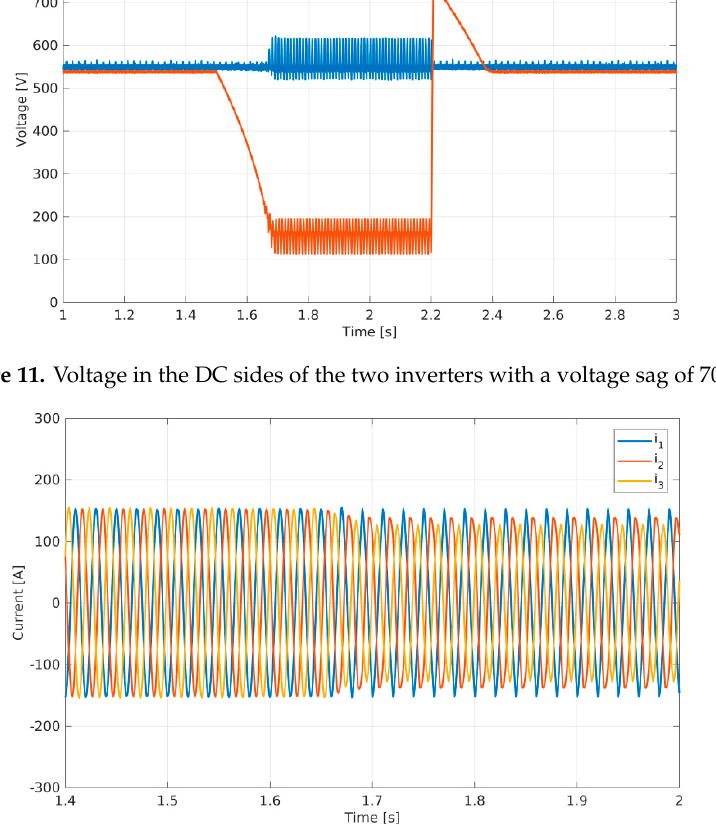
Figure 12. Motor three-phase currents with a voltage sag of 70%.